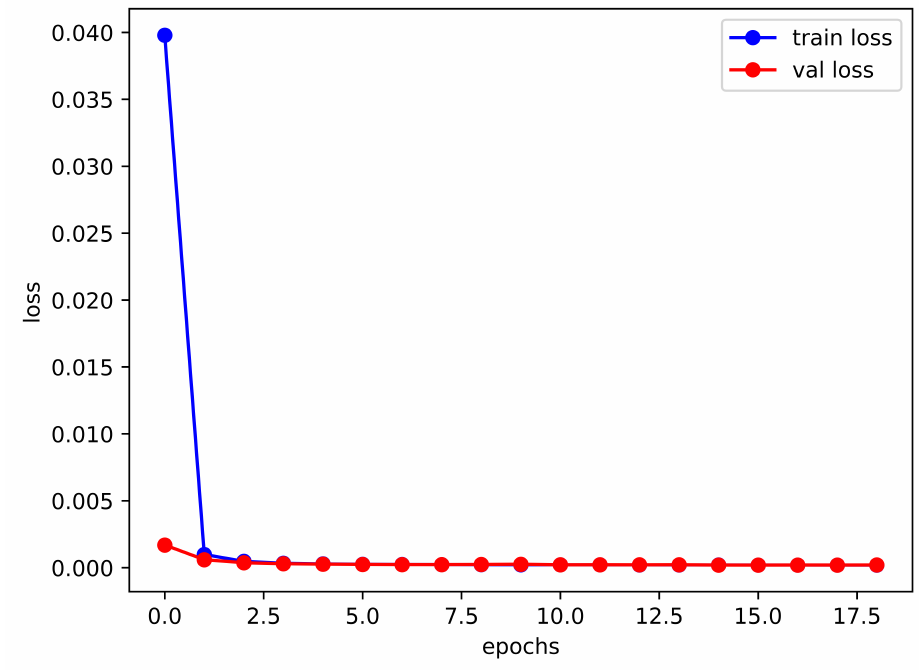
Figure 3. Entropy losses for the FTSE 100 data with maturities from 21 January 2022 to 15 Decem- ber